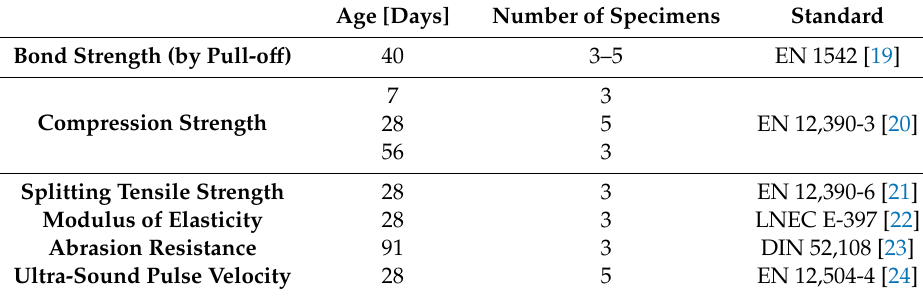
Table 1. Hardened properties of